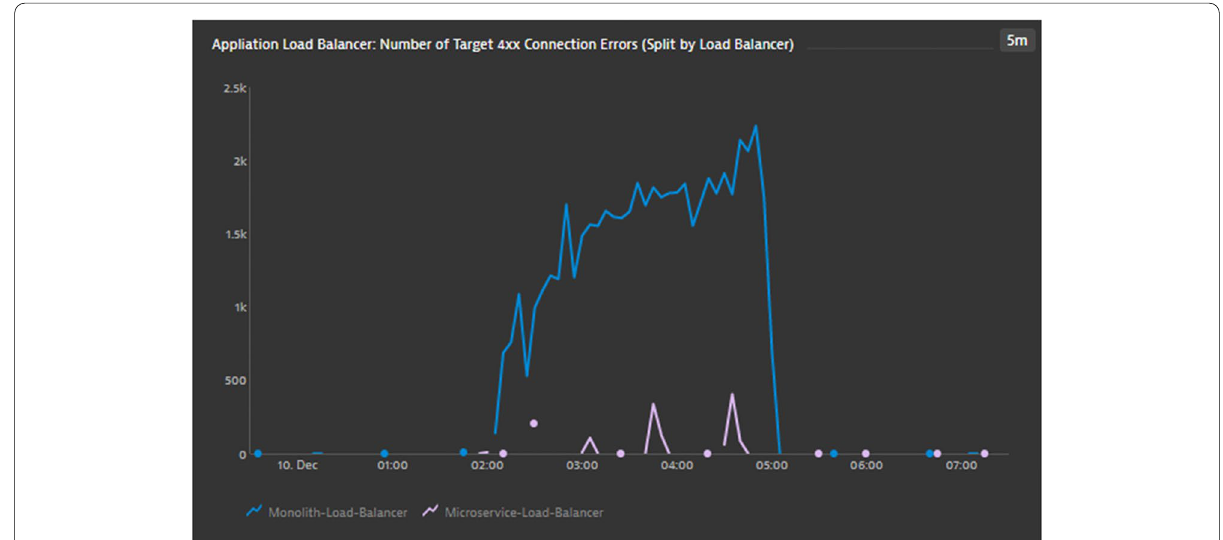
Fig. 15 Total number of 4xx errors, split by load